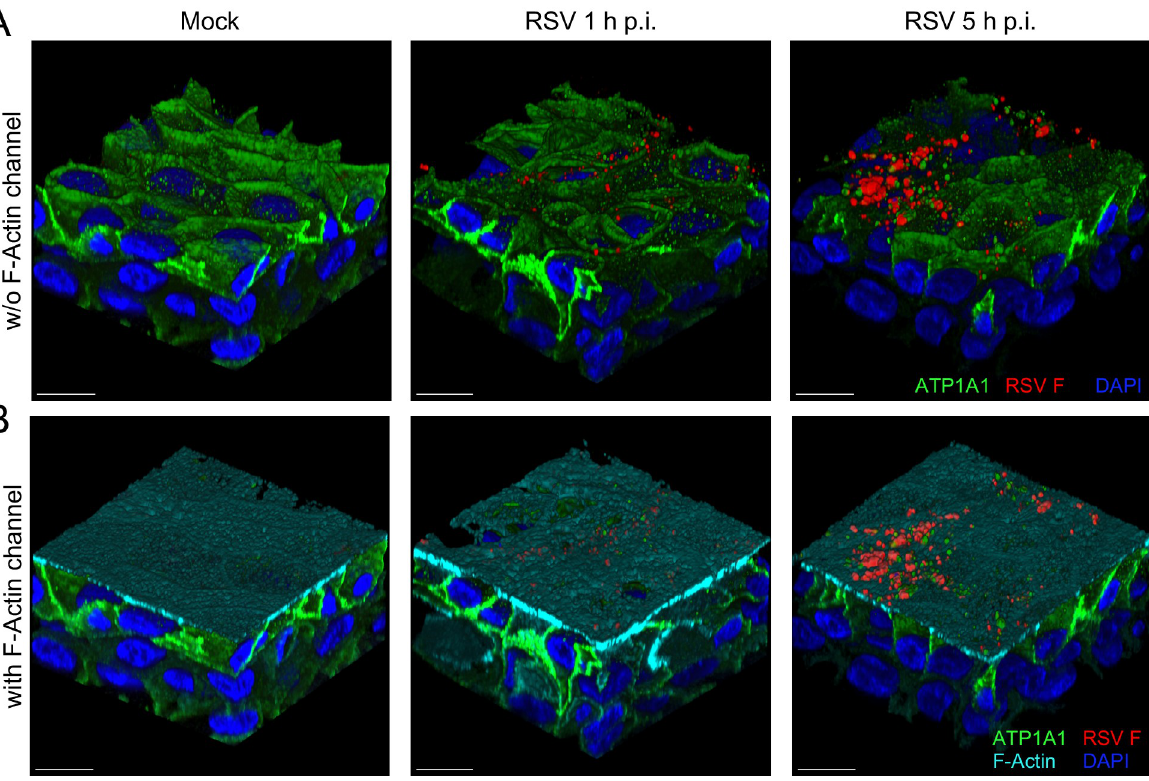
Fig 12. RSV induces ATP1A1 clustering in primary human airway epithelial-air liquid interface (HAE-ALI) cultures. HAE-ALI cultures were inoculated with wt RSV (10 6 PFU/tissue), incubated for 1 or 5 h, fixed and subjected to immunofluorescence staining as described for Fig 3 (ATP1A1, green; RSV F, red; F-Actin, cyan; DAPI; blue). Images are shown without (A) and with (B) F-Actin staining. Images were deconvolved with Huygens Essential deconvolution software (Scientific Volume Imaging B.V, Hilversum, The Netherlands). Scale bars 10 μ